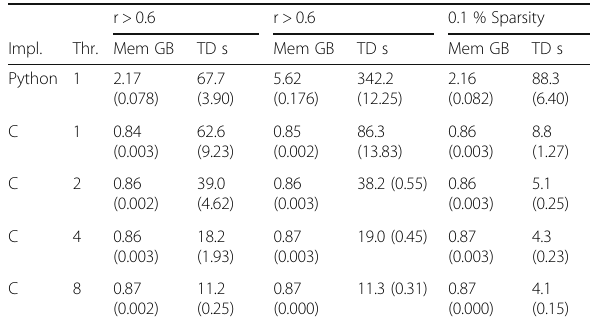
Table 1 (abstract A4). Comparison of the time and memory required by the C-PAC and AFNI implementations to calculate DC (sparsity and correlation threshold) and lFCD on the first resting state scan of the first scanning session for all 36 participants ’ data in the IBATRT dataset r>0.6 r>0.6